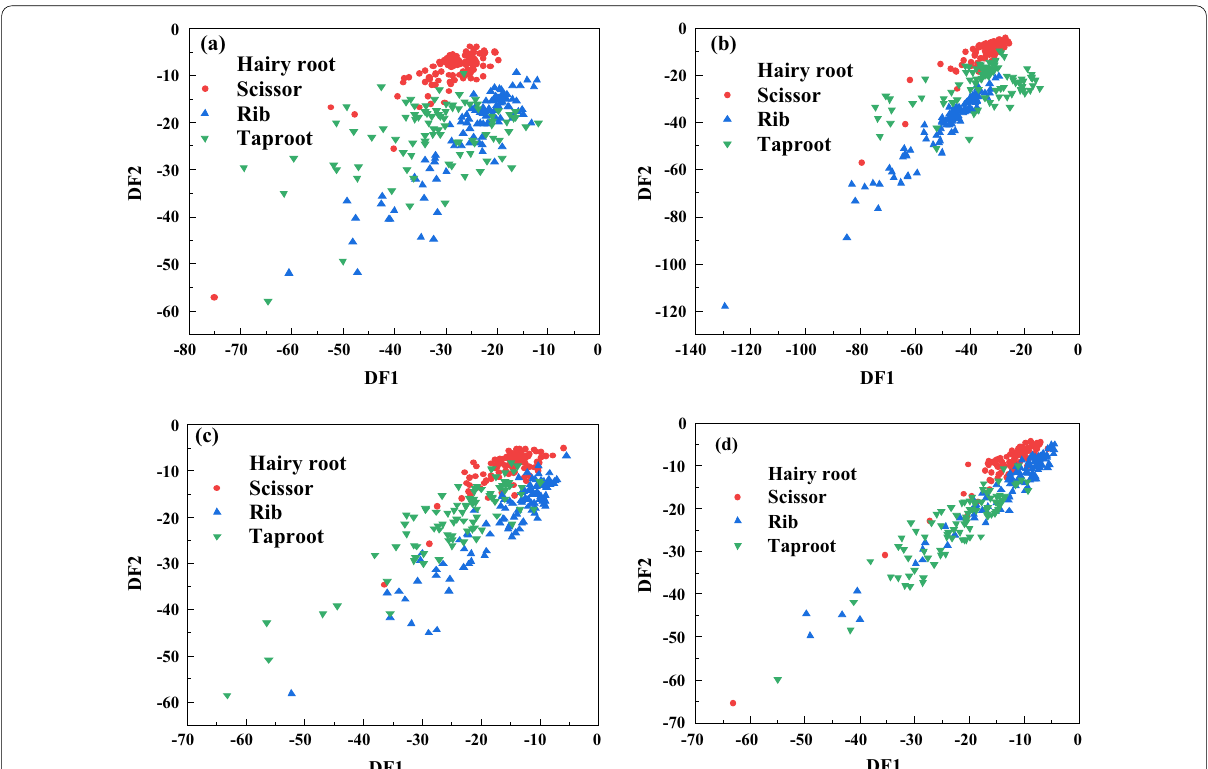
Fig. 6 Plane classification diagram of LDA model for modeling set samples, a is the model without pretreatment, b is the model with baseline correction, c is the model with MSC, and d is the model with